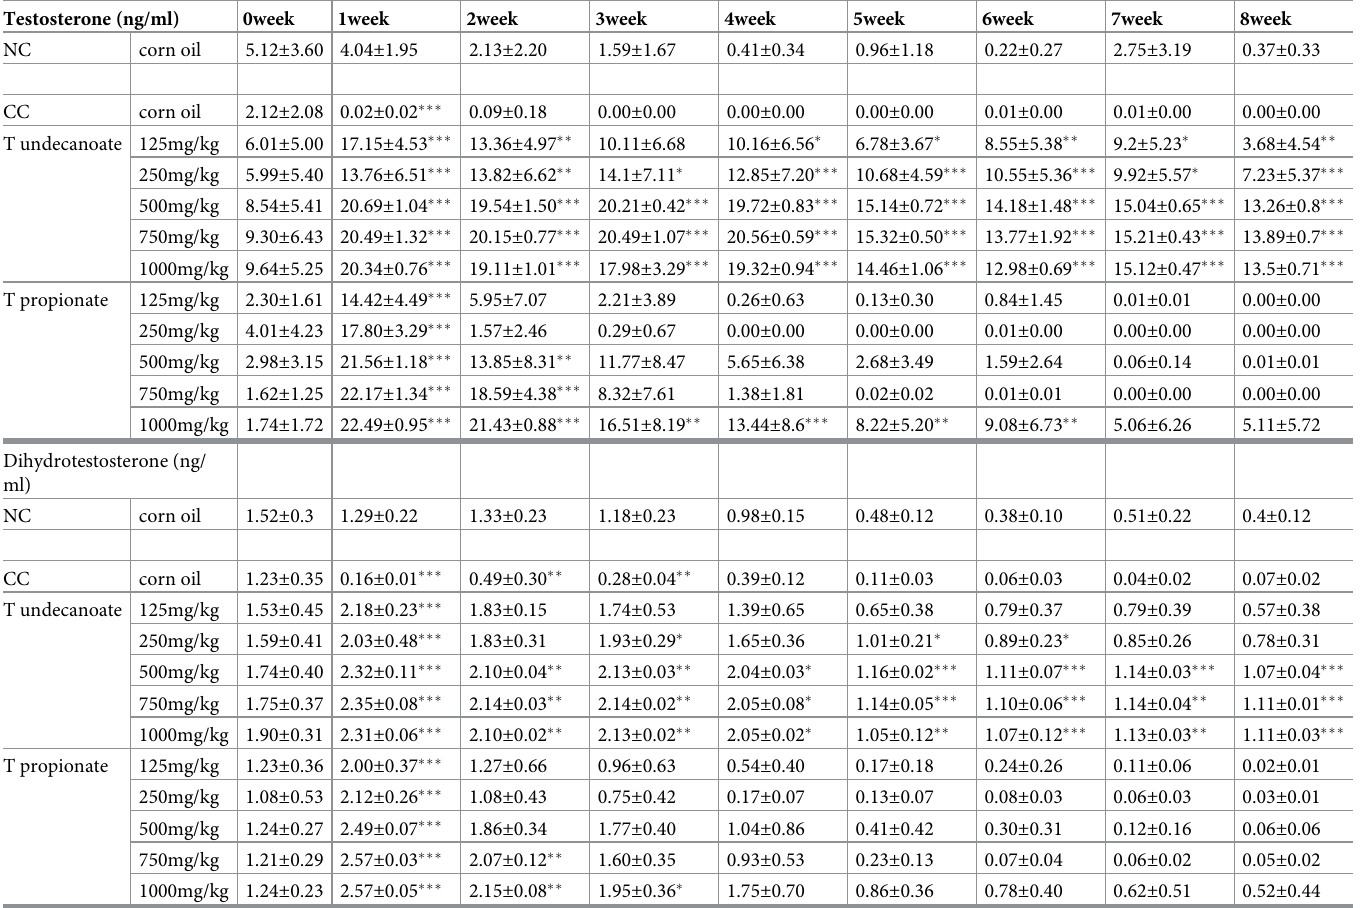
Table 1. Changes in serum levels of testosterone and dihydrotestosterone in the dosage